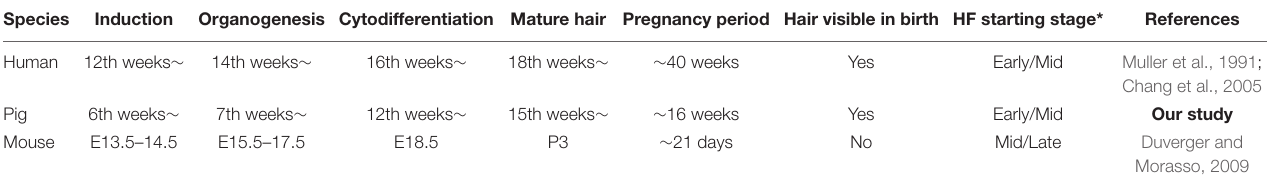
TABLE 3 | Classification of the hair follicle morphogenesis periods in different species.